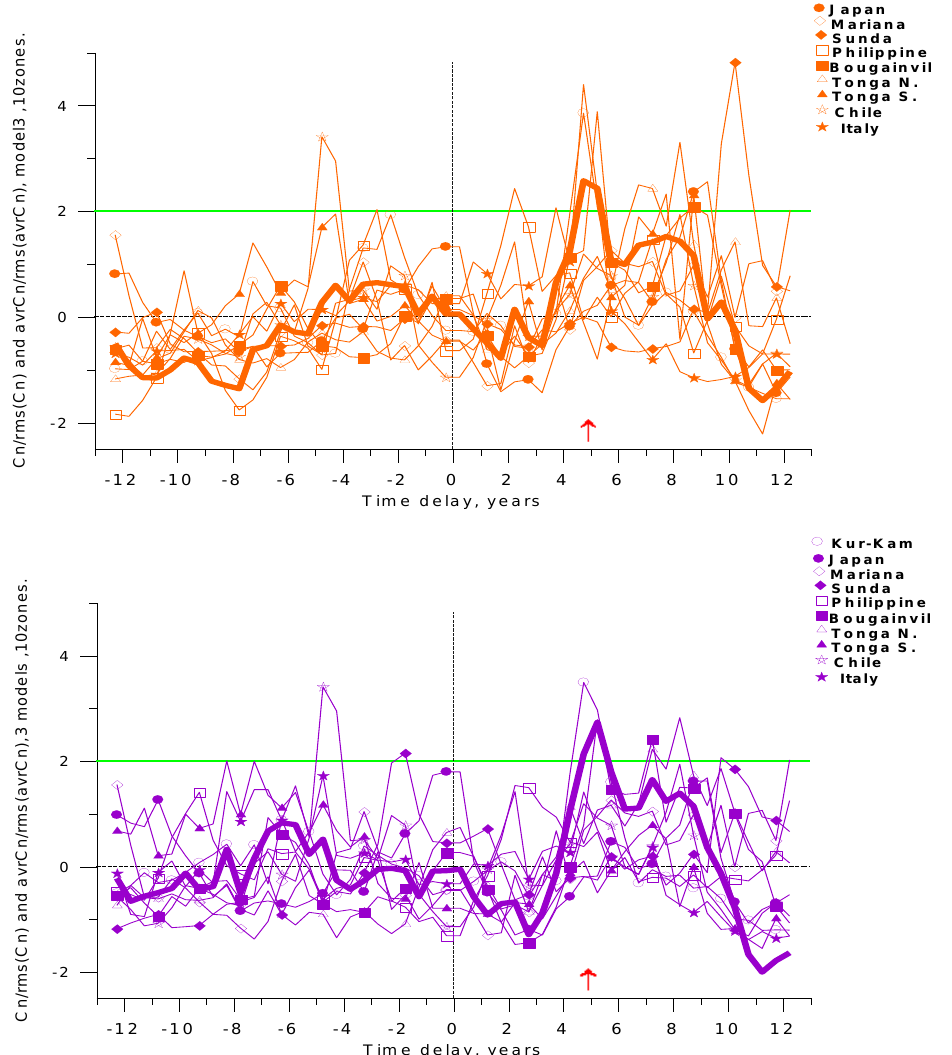
Fig. 4. (a) Results of the correlation analysis on the sense of migration and averaged velocity for the following zones using diffusion trajectory model: open circles: Kurile-Kamchatka; closed circles: Japan; opened diamonds: Mariana; closed diamonds: Sunda; opened squares: Philippines; closed squares: Bougainville; opened triangles: Tonga North; closed triangles: Tonga South; opened stars: Chile; closed stars: Italy. Averaging over all zones is shown by solid line. Estimation of direction and travel time of the migration is shown by an arrow using reliability criteria that is discussed in the text. (b) Results of correlation analysis for all zones using an average over three trajectory models. Legends are the same as in (a).